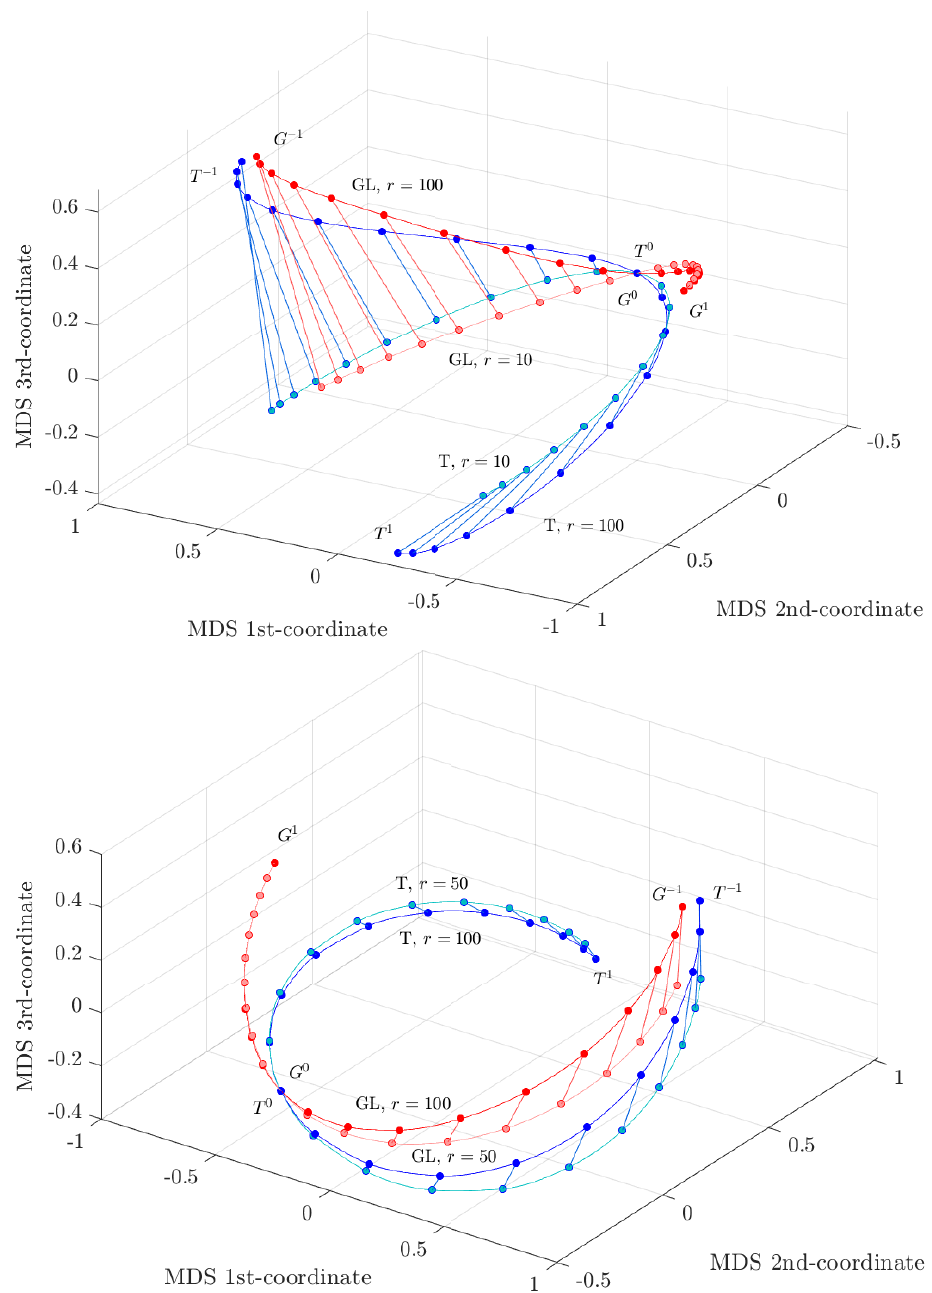
Figure 8. MDS loci comparing the GL and Tustin series for r = 10 ( top ) and r = 50 ( bottom ) with the ones for r = 100, using the ArcCosine distance d Ac